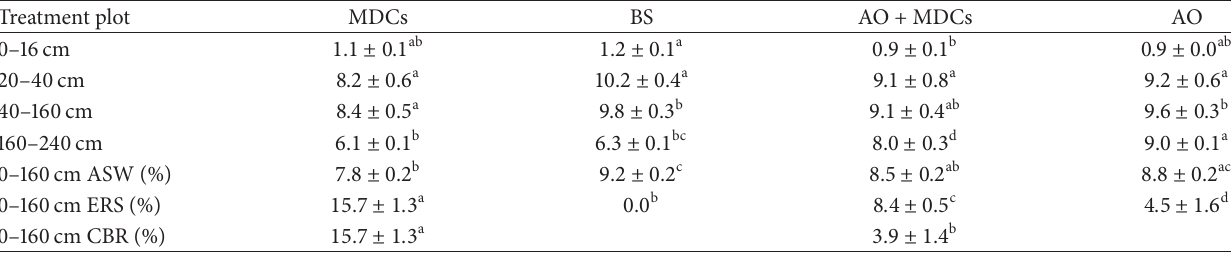
Note: different letters in the same column indicate significant differences at 5% probability level. Average soil moisture content, ASW.